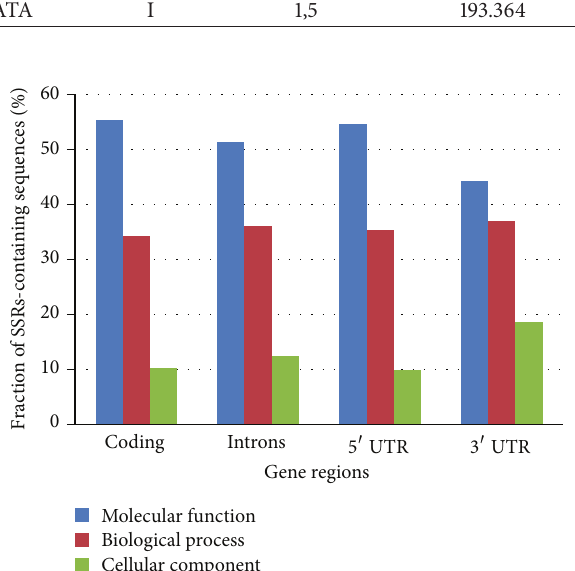
Figure 6: Classification of the sequences of the different cassava gene regions that contain SSRs, according to the three main categories from